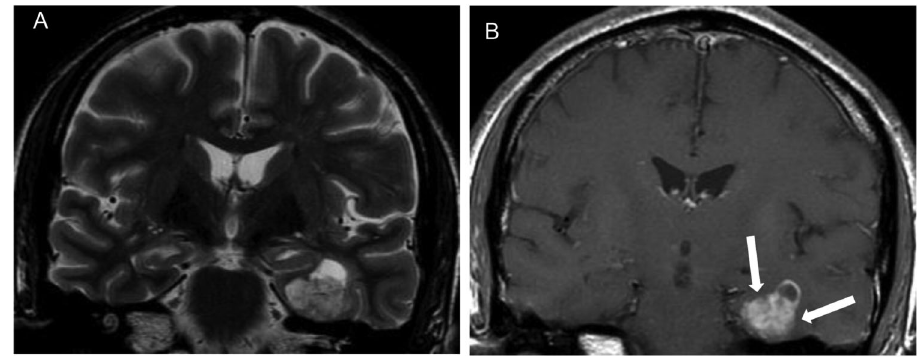
Figure 6 - A MRI of a ganglioglioma in a 45-year-old man with refractory left partial mesial temporal lobe epilepsy. A) A coronal T2-weighted image and B) a contrast-enhanced coronal T1-weighted image showing a solid-cystic lesion in the mesial left temporal lobe with intense enhancement of the soft tissue component (white arrows).